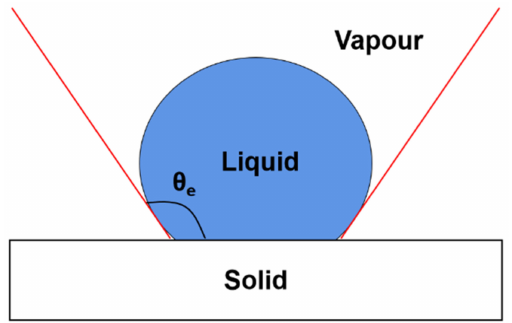
Figure 11. Schematic diagram of water contact